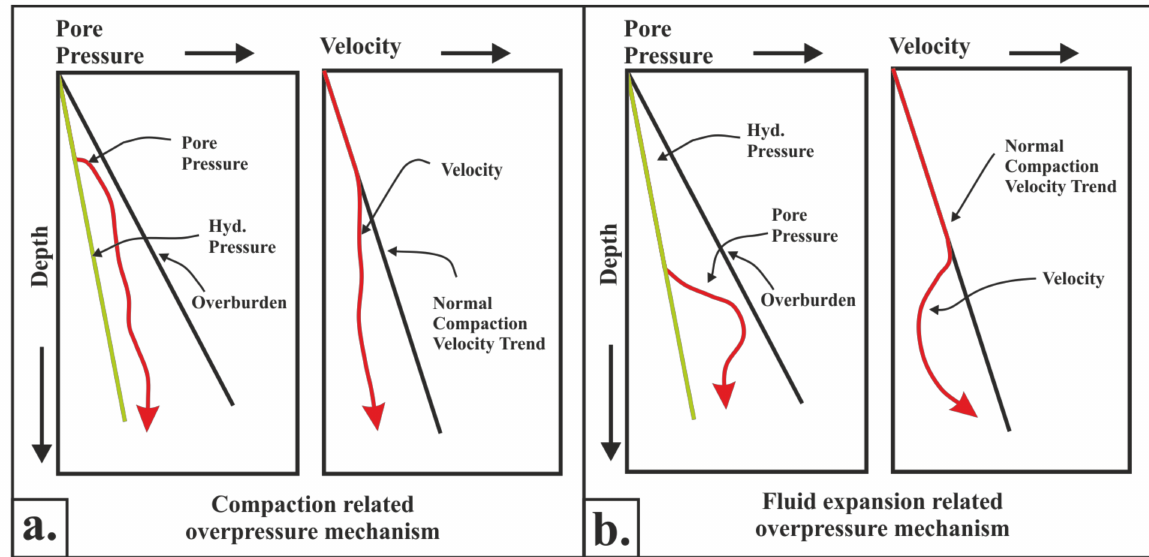
Figure 5. The effect of the two main overpressure generation mechanisms on the compressional wave velocity and the pore pressure-depth profiles: ( a ) typical profiles of the undercompaction driven overpressure; ( b ) effects of the fluid